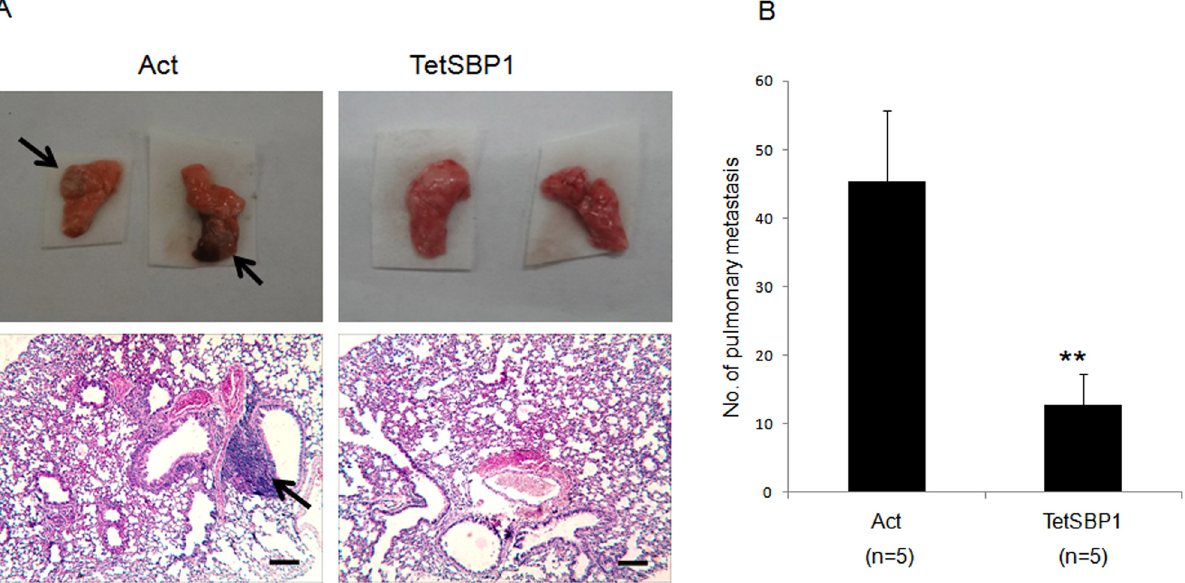
Fig 2. SBP1 induction suppressed tumor metastasis in vivo (A) Representative images of lungs and hematoxylin and eosin (HE)-staining of lungs isolated from mice that received tail vein injection of HCT116-Act cells (Act) and HCT116-TetSBP1 cells (TetSBP1). Each group contains 5 mice. Arrows illustrates the visible nodules and metastatic nodules in lung. Scale bar = 200 μ m. (B) SBP1 induction inhibits tumor metastasis in vivo . The numbers of pulmonary metastatic nodules were counted under microscope and analyzed with Student ’ s t-test. Results are shown as mean ± SD. ** P < 0.01.